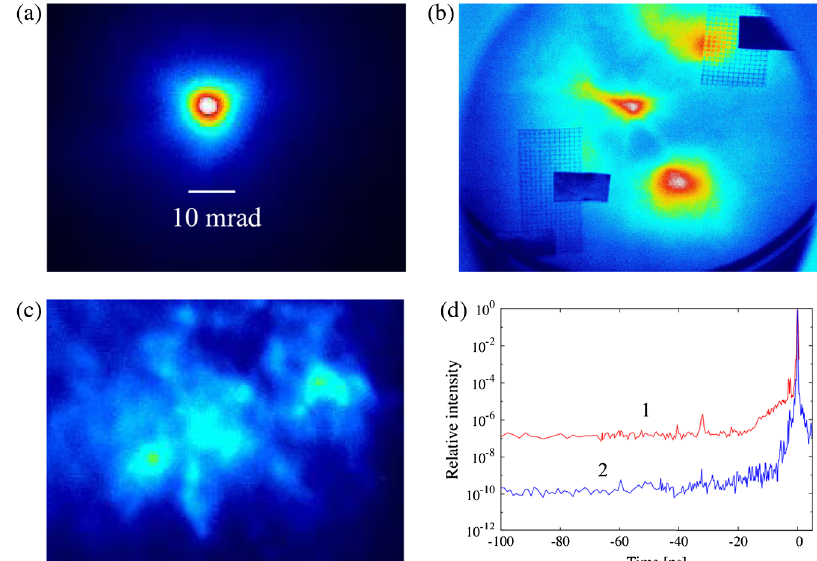
FIG. 2. Electron beam profiles (a) in the case of high-intensity prepulse with the external magnetic field, (b) low-intensity prepulse in the magnetic field, and (c) high-intensity prepulse without the magnetic field for the gas density ∼ 3 . 4 × 10 19 cm − 3 . (d) Prepulse shapes in hundred ps regime measured by third-order cross correlator.